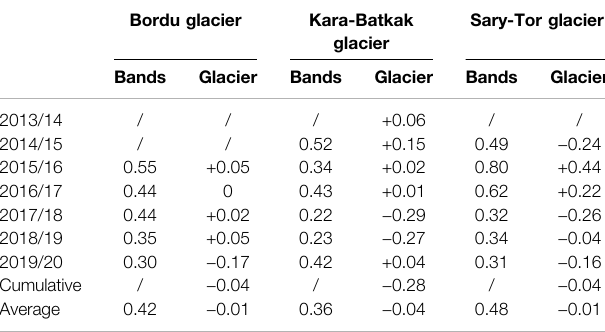
TABLE 7 | RMSE values between modelled and observed mean speci fi c mass balance in individual bands (Bands) and difference between the modelled and observed glacier wide mean speci fi c mass balance (Glacier). Values are in m w.e. yr − 1